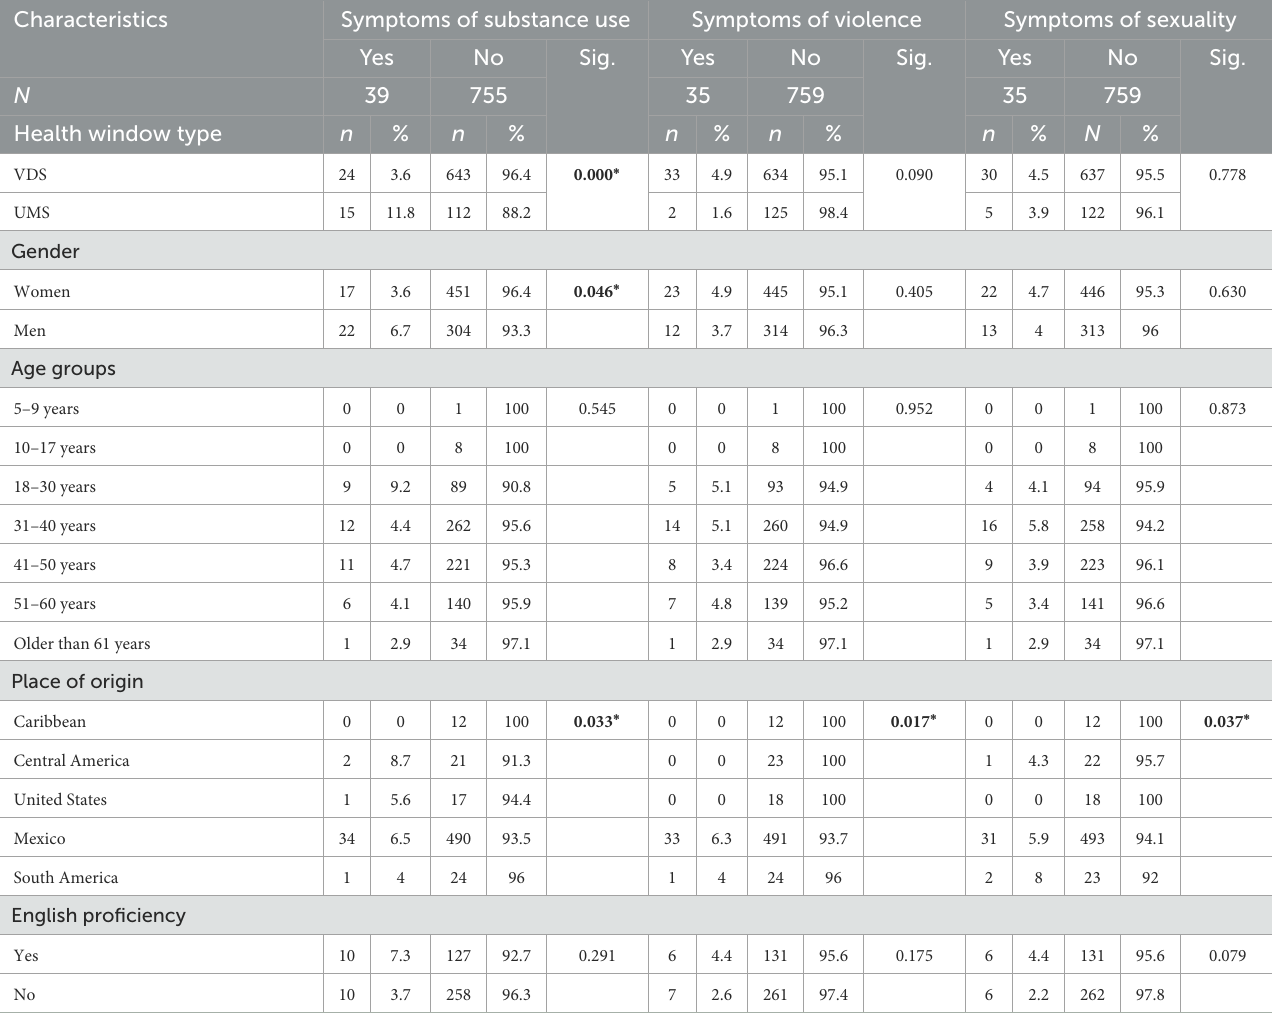
TABLE 4 Distribution of sociodemographic characteristics among the population with or without mental health symptoms/problems of substance consumption, violence or sexuality for screenings done at HW and MHU during 2021.